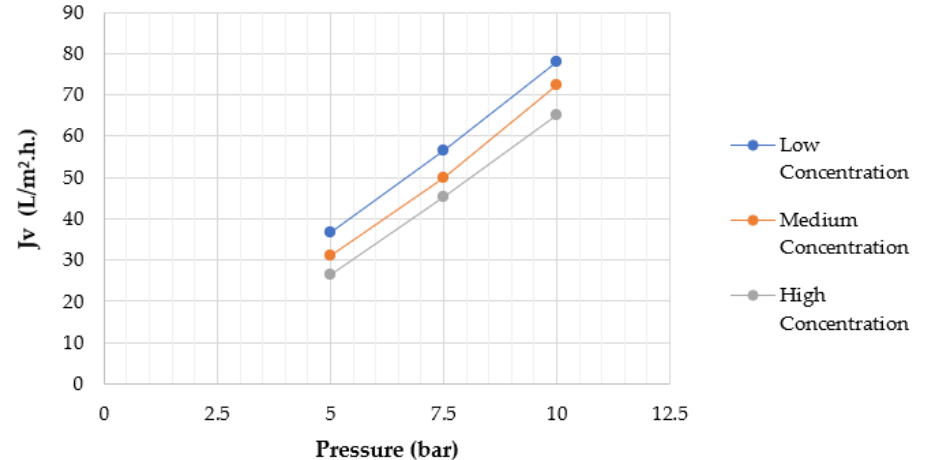
Figure 5. Volumetric flux normalized to 25 ◦ C versus pressure for Pb solutions (ULP-2540).